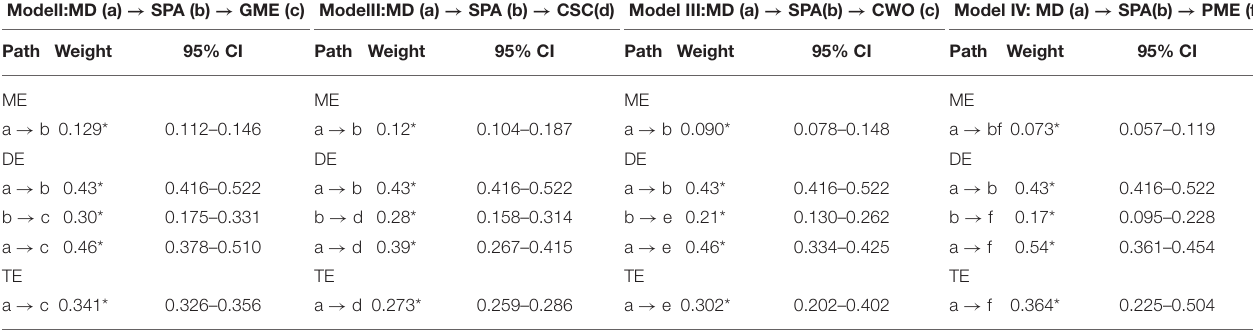
TABLE 6 | Mediating effect of social physique anxiety scores on muscle dysmorphia and body checking